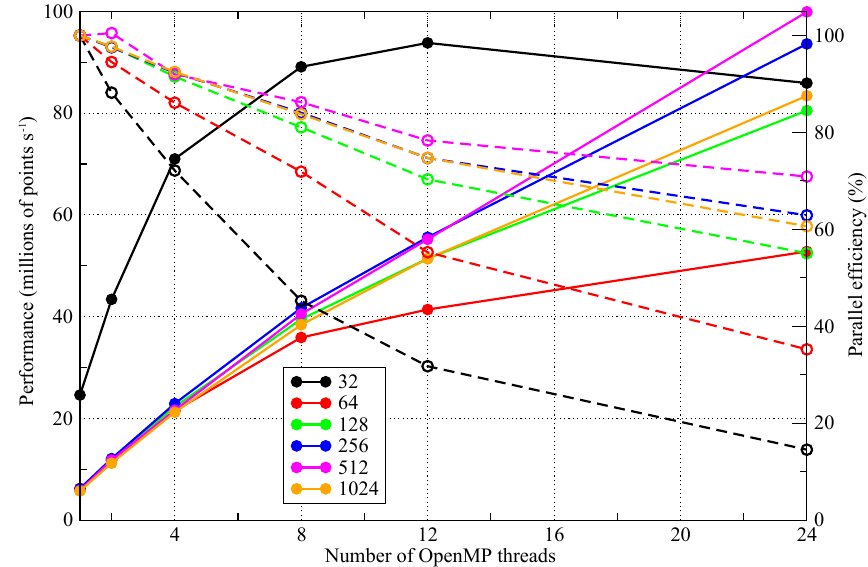
Figure 6. The scaling behaviour of the most performant OpenMP-parallel version of PSyKAl NEMOLite2D for the full range of domain sizes considered on the CPU. Results are for the Intel compiler on a single Intel Ivy Bridge socket. The corresponding parallel efficiencies are shown using open symbols and dashed lines. The 24-thread runs employed hyperthreading.